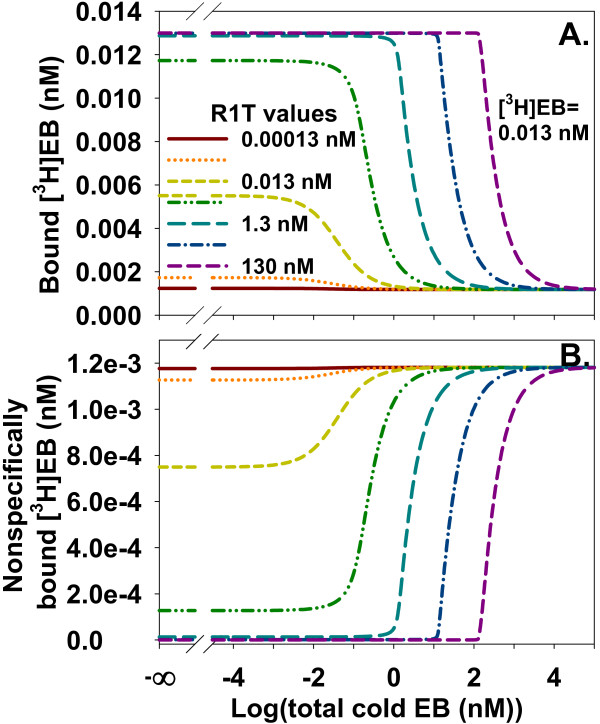
The contribution of NSB to total binding of homologous competition data depends on the concentration of cold EB when ligand depletion is significant. A. The presence of NSB (α = 0.1, [3H]EB = 0.013 nM) displaces the baseline of bound [3H]EB above the x-axis. Ligand depletion does not affect the size of this signal at large concentrations of cold EB, which in this case is equivalent to the apparent NSB. As anticipated from Figure 7, increasing ligand depletion in the presence of NSB shifts IC50 rightward and distorts the sigmoidal shape of the competition curve. R1T values increase in one log unit increments. B. NSB is not constant along the x-axis. Increasing ligand depletion with increasing R1T reveals the sigmoidal or distorted sigmoidal appearance of NSB as a function of cold EB and shifts the NSB curve rightward. Conditions and legend are the same as in A.